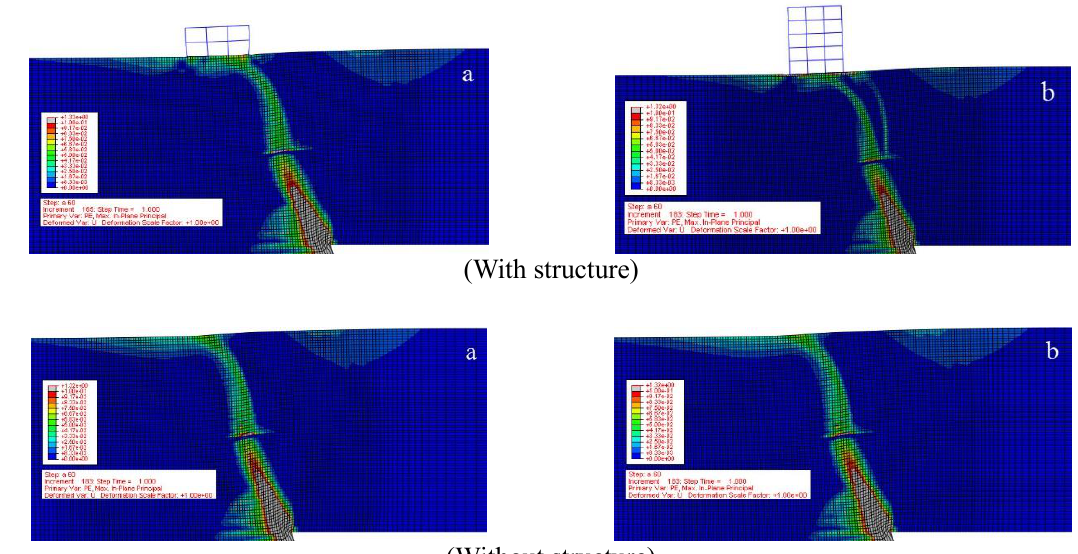
Fig. 16. Fault route in two soil layer with MS-LS density: (a) 2 floors and (b) 5 floors.